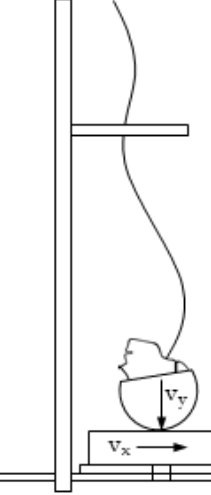
Figure 3. KTH Oblique Test Rig in the initial position ( left ) and at the time of impact ( right ). v y : vertical velocity calculated from drop height. v x : horizontal velocity calculated from light gate.